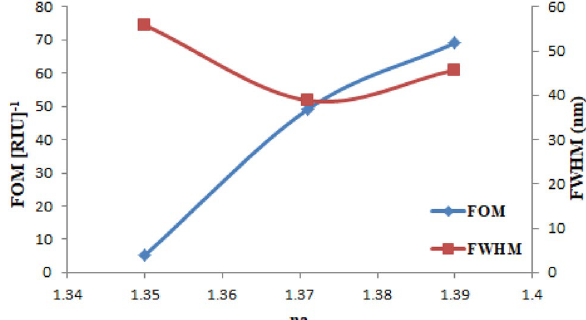
Figure 23. Presents the FOM and FWHM at n a = 1.35, 1.3710, and 1.39 for NaCl-DI water, sucrose-DI water, and glycerol-DI water.